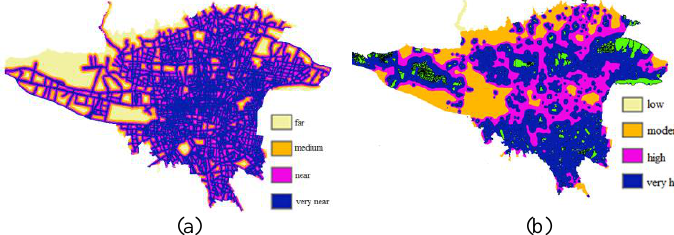
Figure 3. The classified maps to show the effect of distance